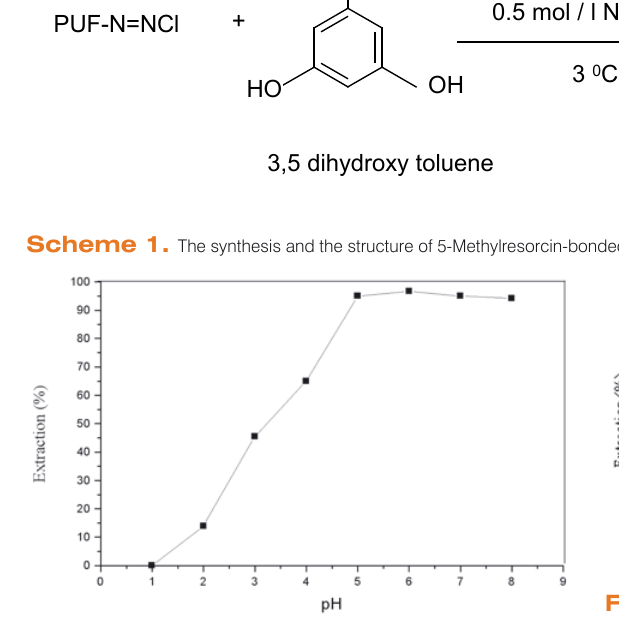
Figure 1. Effect of initial pH on the extraction of Hg(II) onto MR-PUF average of three determinations.